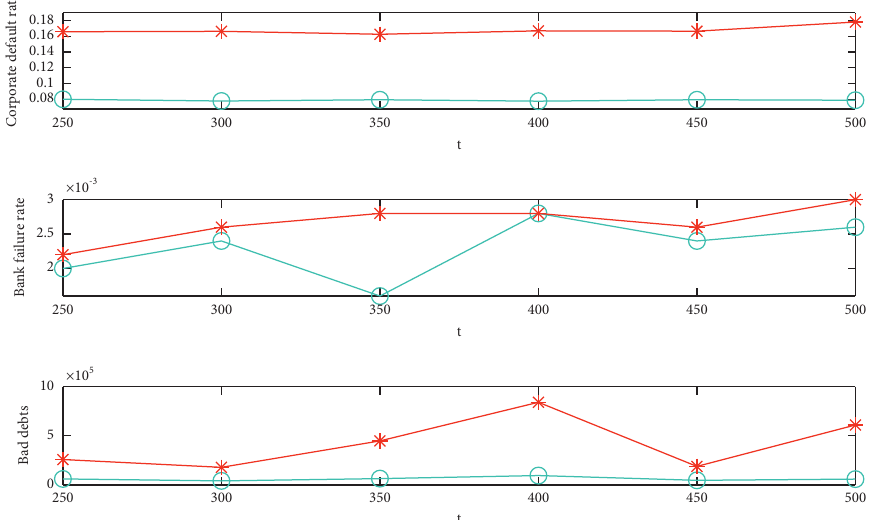
Figure 11: Consumer market shocks and the evolution of risk contagion between banks and enterprises.